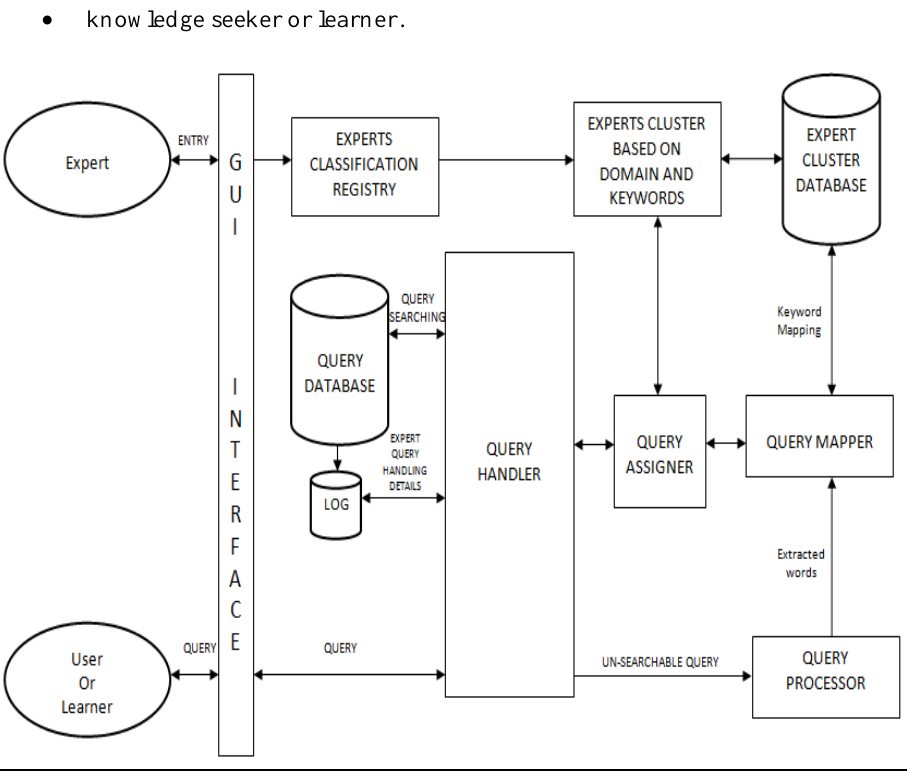
Figure 1 . Dynamic query handling